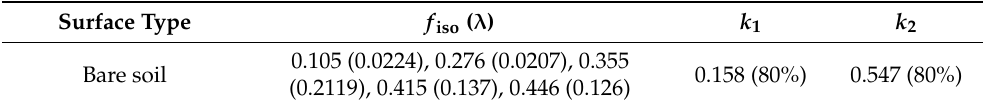
Table A3. The surface model